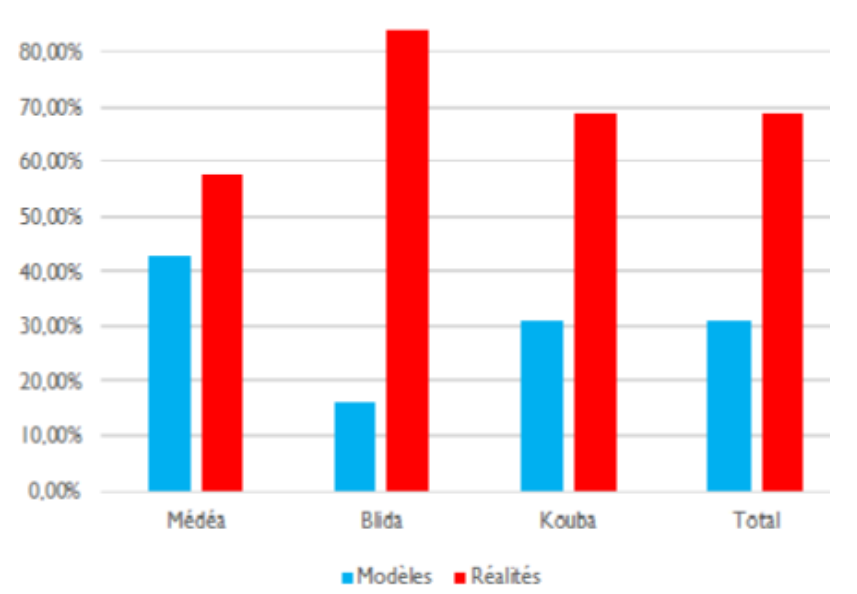
Fig. 4-b. Résultats de l’item 4.b. La différenciation entre modèle et